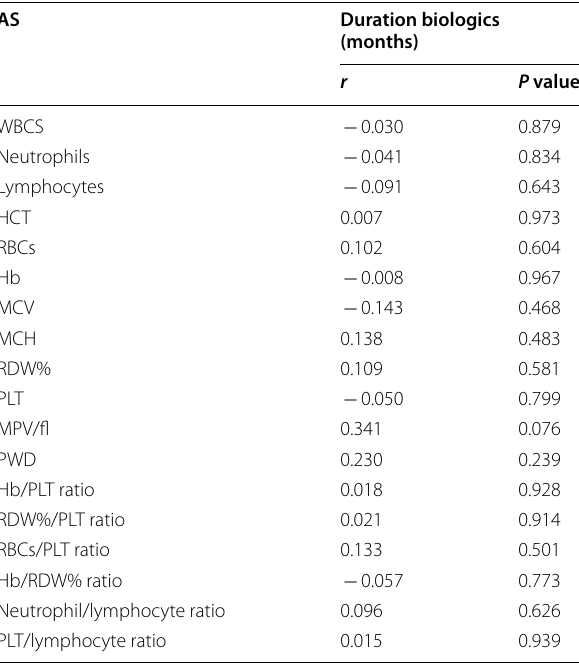
Table 8 Correlation between the WBCs, RBCs, and Plptelets indices with duration of biologic